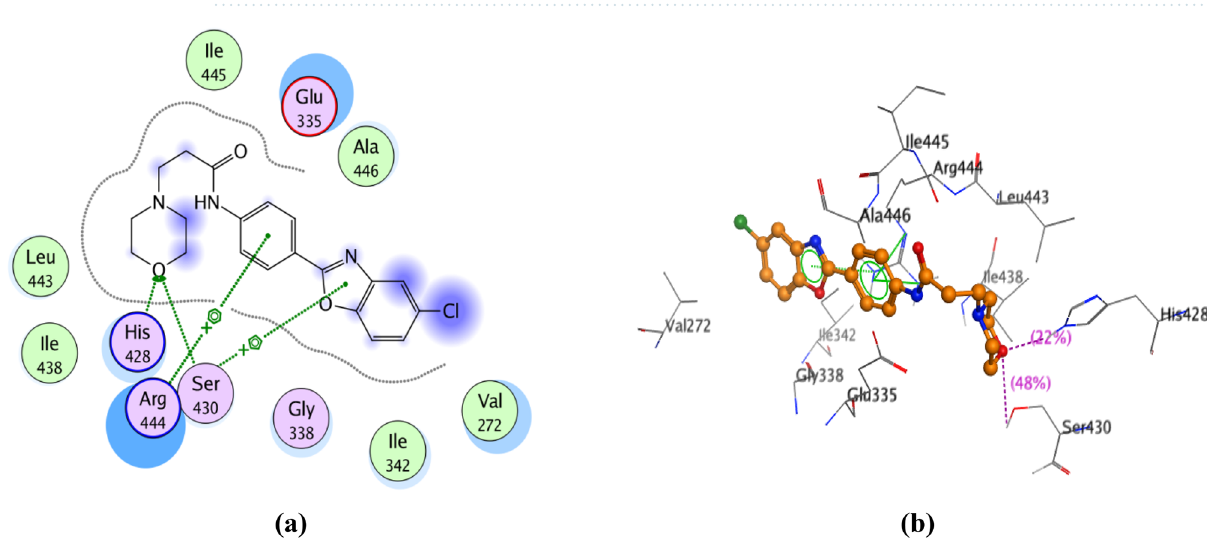
Figure 13. ( a ) 2D view of the interactions between 12 and PARP-2 enzyme active site. ( b ) 3D view of the interactions between 12 and PARP-2 enzyme active